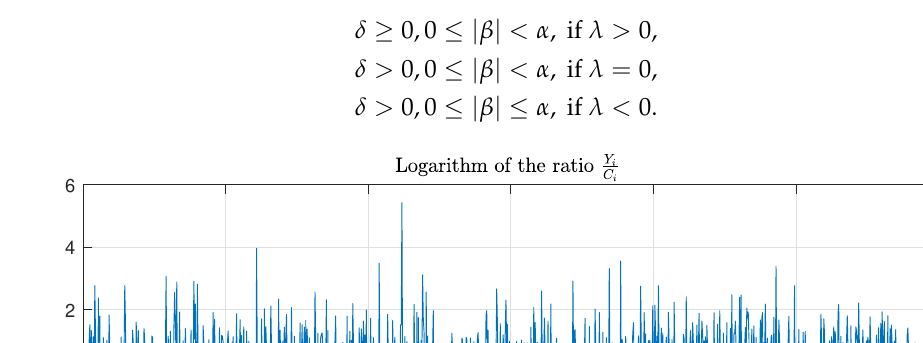
Figure 3. Logarithm of the ratio Y